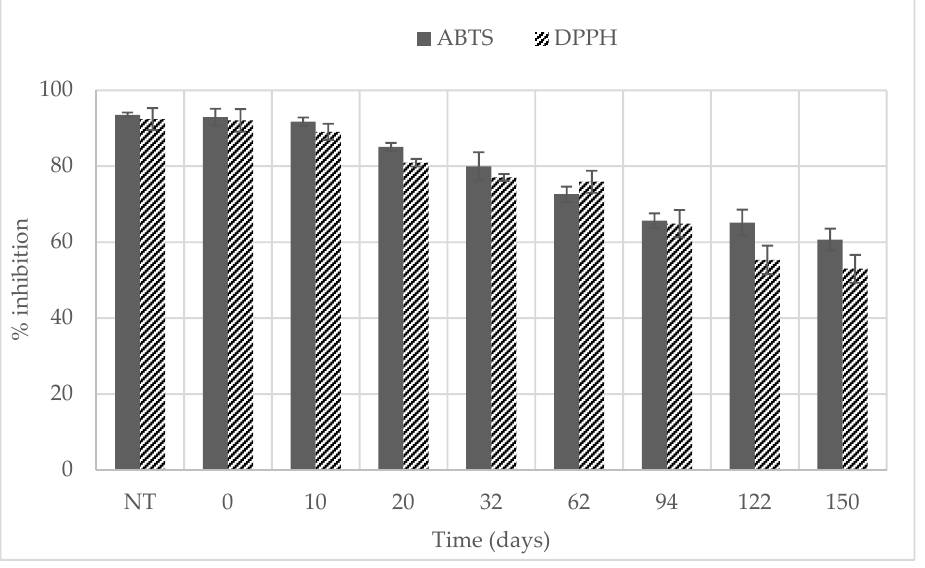
Figure 3. Radical scavenging activity of untreated and HPP-treated sour cherries during refrigerated storage.